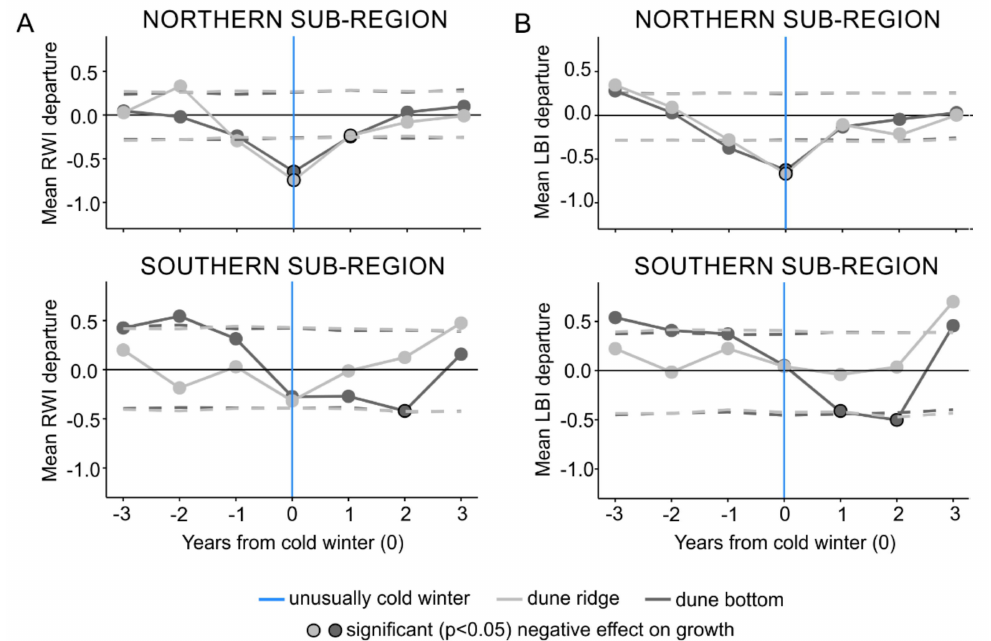
Figure 5. The results of superposed epoch analysis for the subregion-specific cold winters and the ridge-north, bottom-north, ridge-south, and bottom-south datasets of ring width ( A ) and latewood blue intensity ( B ) parameters. Light and dark gray represent dune ridge and bottom microsites, respectively. Vertical blue lines show an event year (i.e., superposed subregion-specific cold winters), and circles with black contour present significant negative effect on growth. Dashed lines represent significance at p <